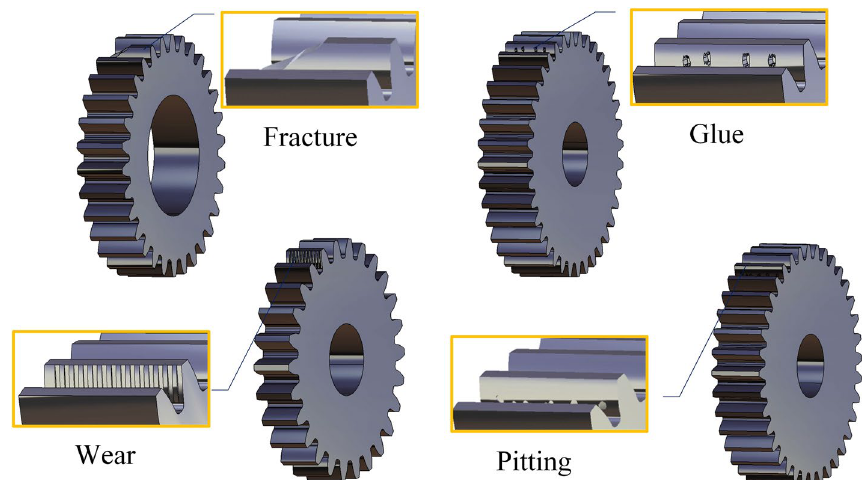
Fig. 1 Four typical gear defects